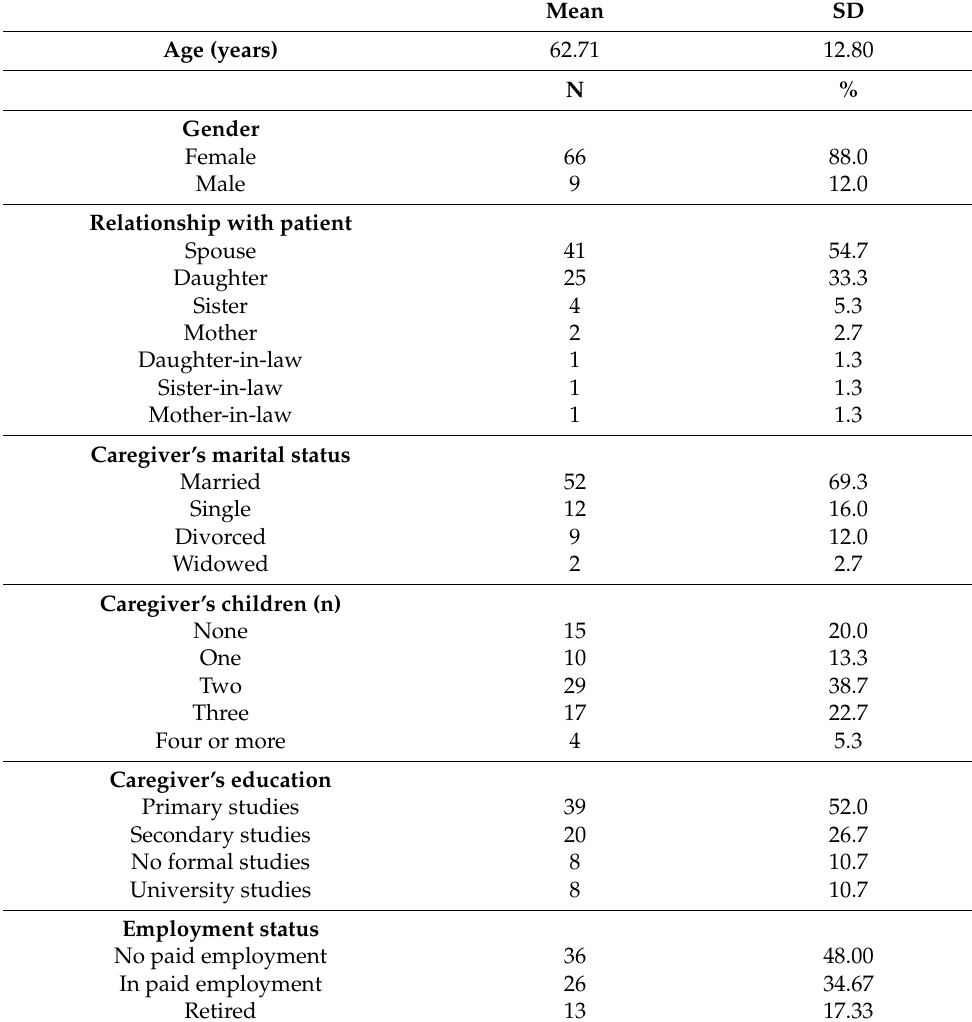
Table 1. Demographic characteristics of the family caregivers (n =